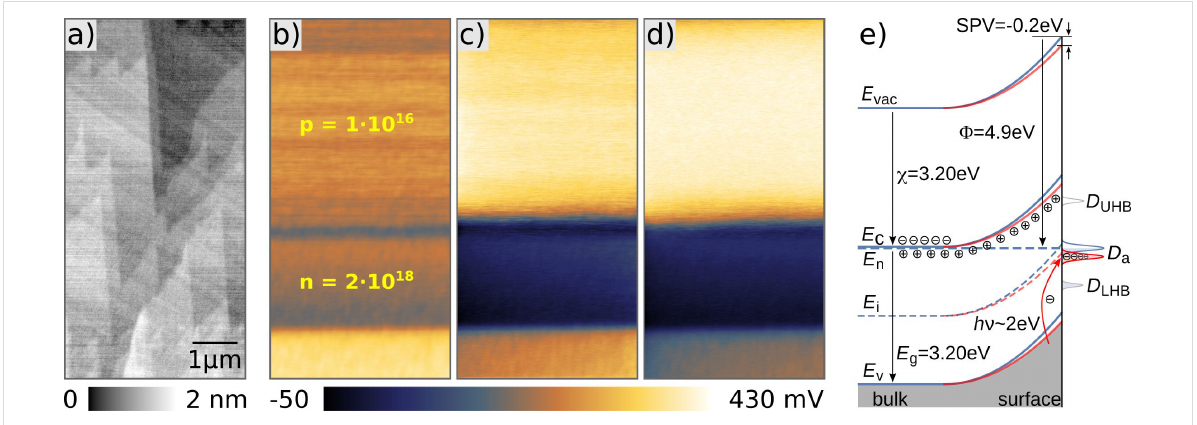
Figure 6: a) Topography, b) dark KPFM and c) 30% laser-power illuminated (470–480 nm and a maximum power of 50 mW) KPFM images of a SiC p/n-junction. The scan size is 4 × 8 μ m 2 . d) 100% laser- power illuminated KPFM image. e) shows a schematic band diagram of the surface band bending as well as the characteristic energies for the n-doped SiC sample including known defect states in dark (blue) and under illumination (red). Under illumination electrons are excited to the acceptor-type defects D a and the band-bending is reduced, details are explained in the